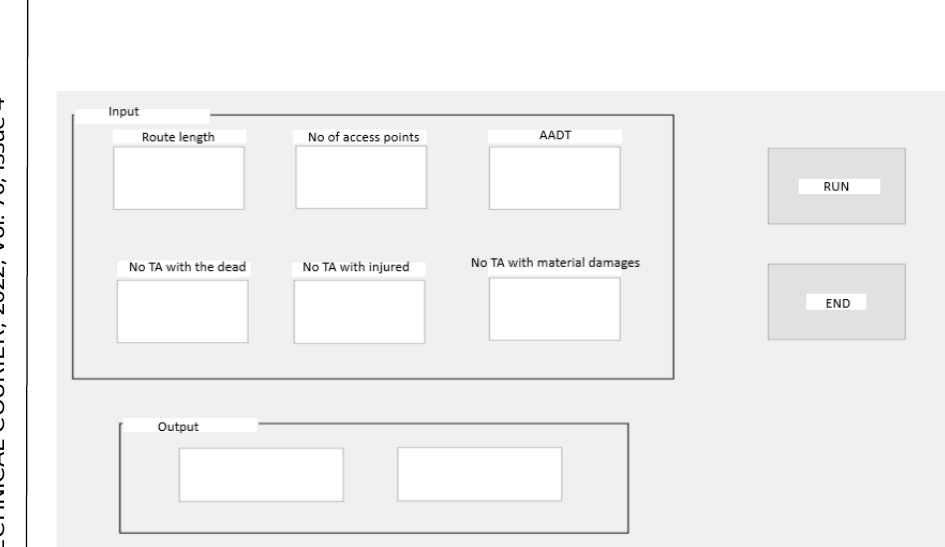
Figure 5 – Window for entering the input values into the system and displaying the output values from the